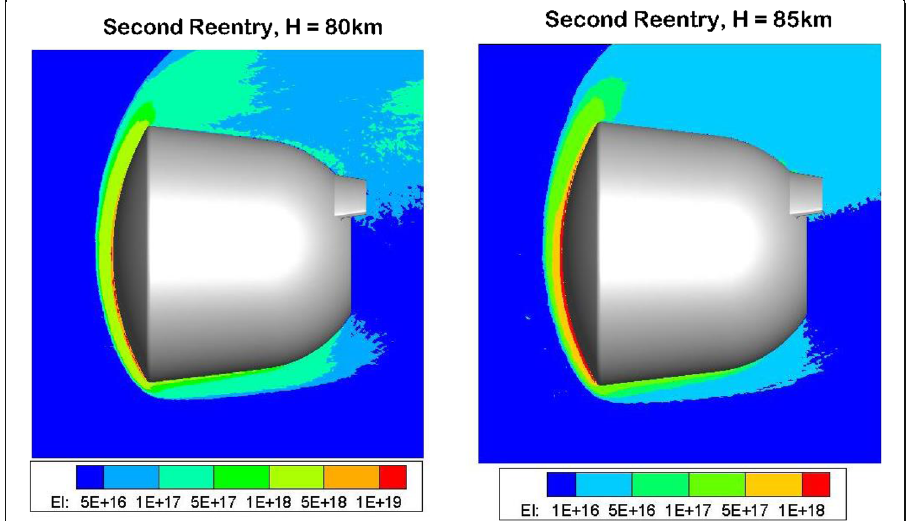
Fig. 21 Electron number density distributions of the lunar exploration type capsule at different altitudes for the second reentry (Unit: /m 3